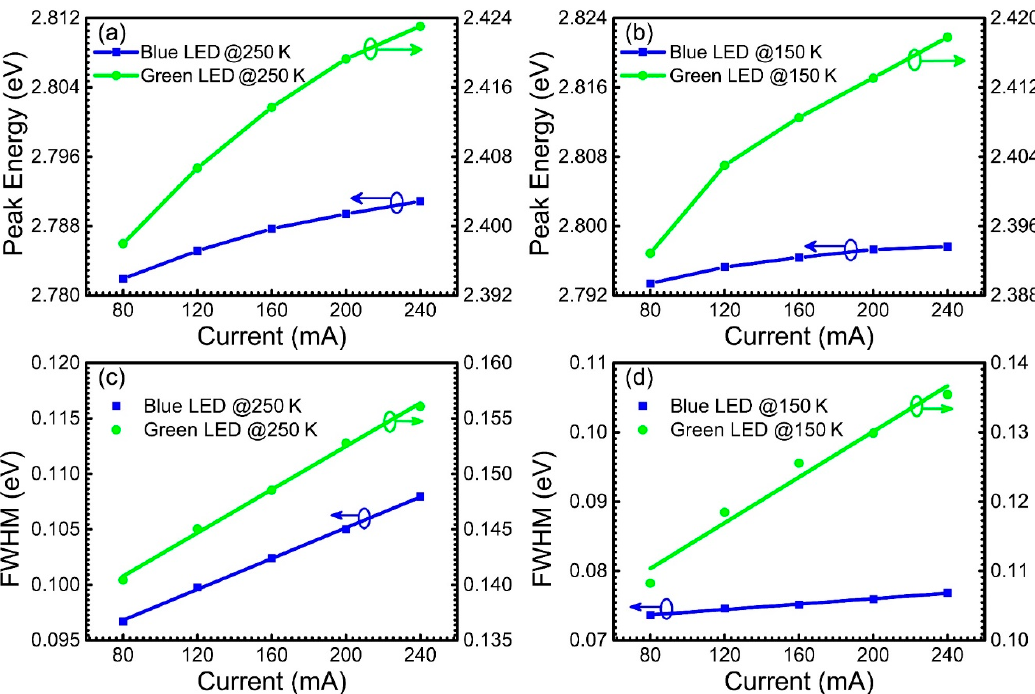
with increasing current density. The reason is discussed in the last paragraph. However, in the low- temperature range (below 150 K), the emission peak energy, FWHM, and the radiation power of the blue LED showed only a slight change with increasing current, while the corresponding values of the green LED still increased strongly with increasing current, as shown in Figures 6 and 9b,d. This difference can be explained by the band filling in real space of the LED at low temperatures, as will be discussed below.